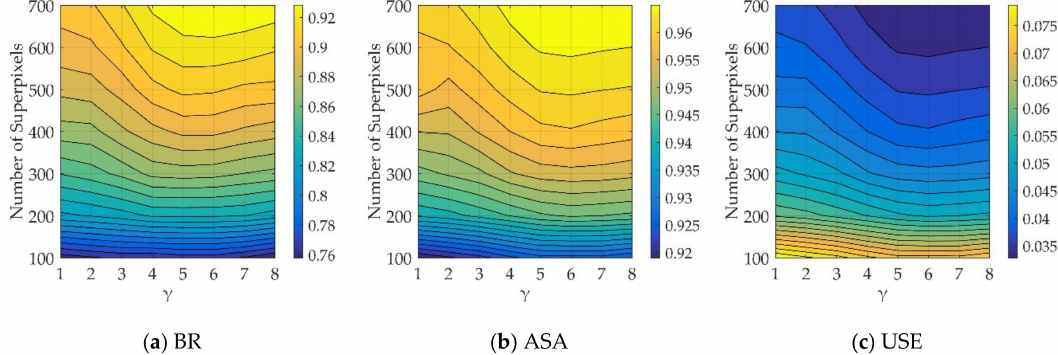
Figure 3. The performance metrics of our approach with di ff erent γ